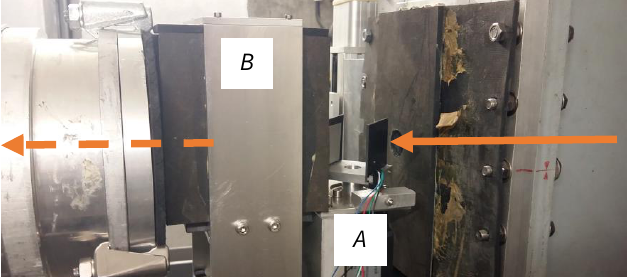
Fig. 3. Fast shutter (A) and polyethylene shutter (B) installed downstream the neutron guide line. The impinging neutron beam is featured by a solid arrow before and by a discontinuous arrow after being shaped by the